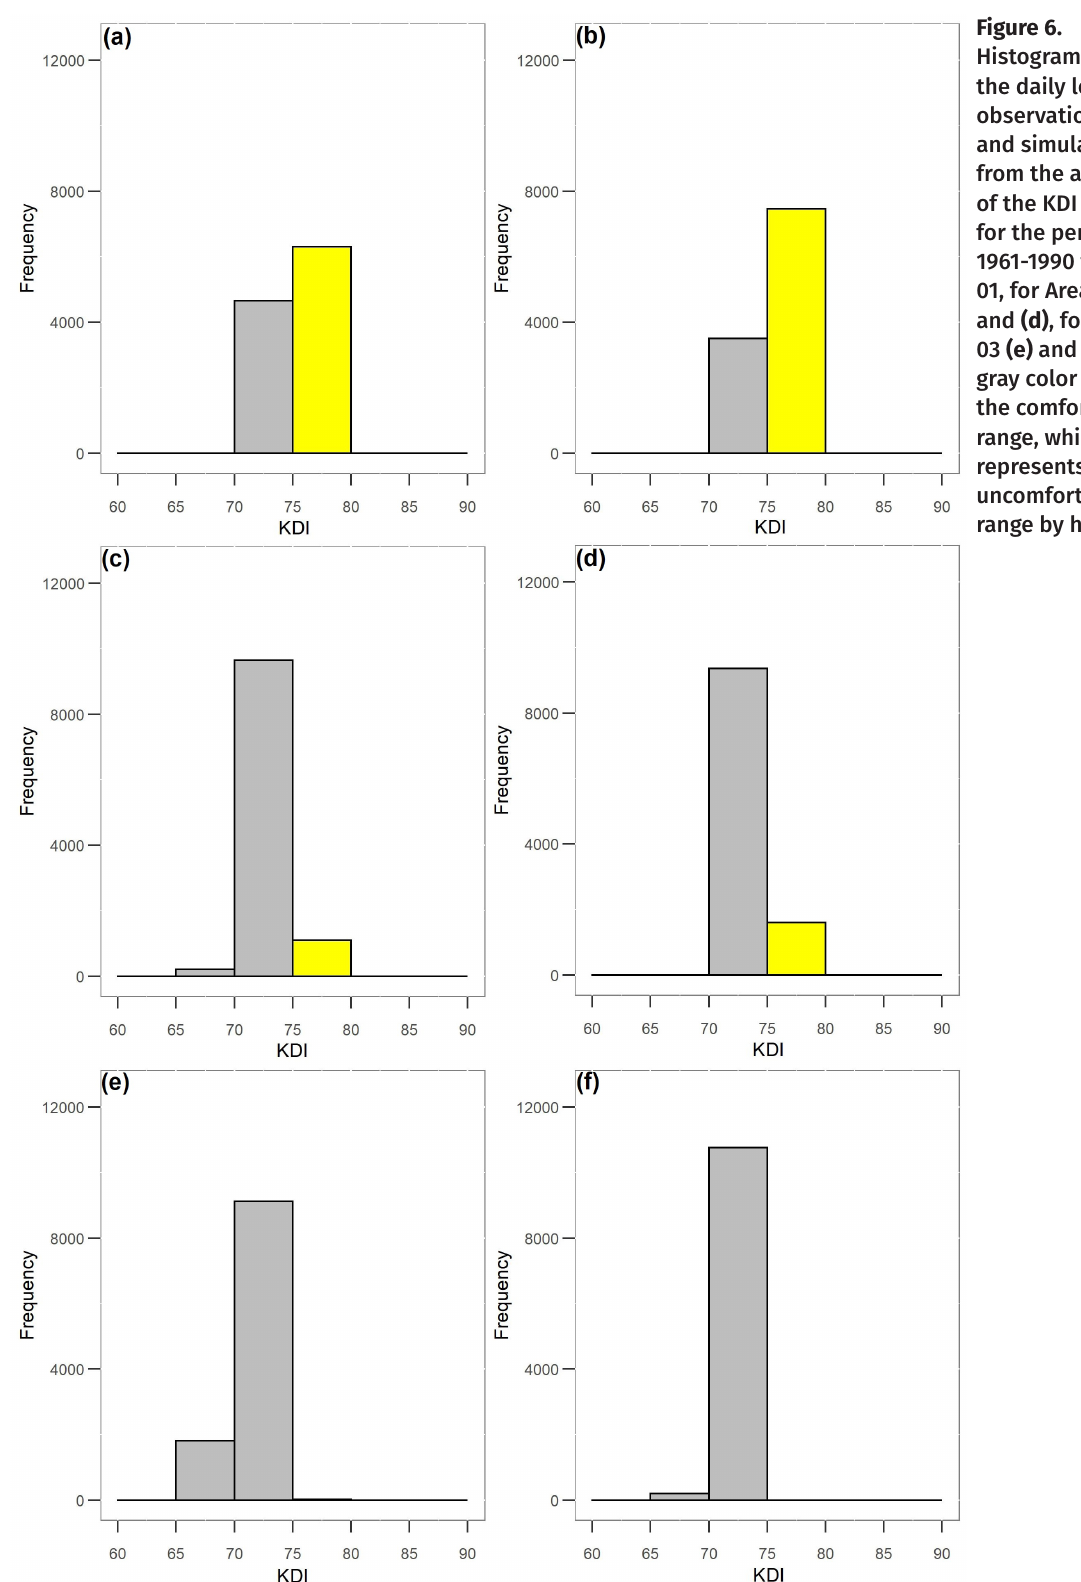
Figure 6. Histograms of the daily log of observations (a) and simulations (b) from the average of the KDI models for the period 1961-1990 for Area 01, for Area 02 (c) and (d) , for Area 03 (e) and (f) . The gray color indicates the comfortable range, while yellow represents the uncomfortable range by